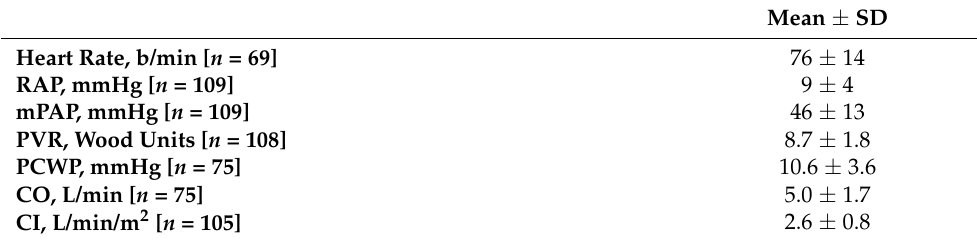
Table A2. Additional Hemodynamic Characteristics of the Cohort.